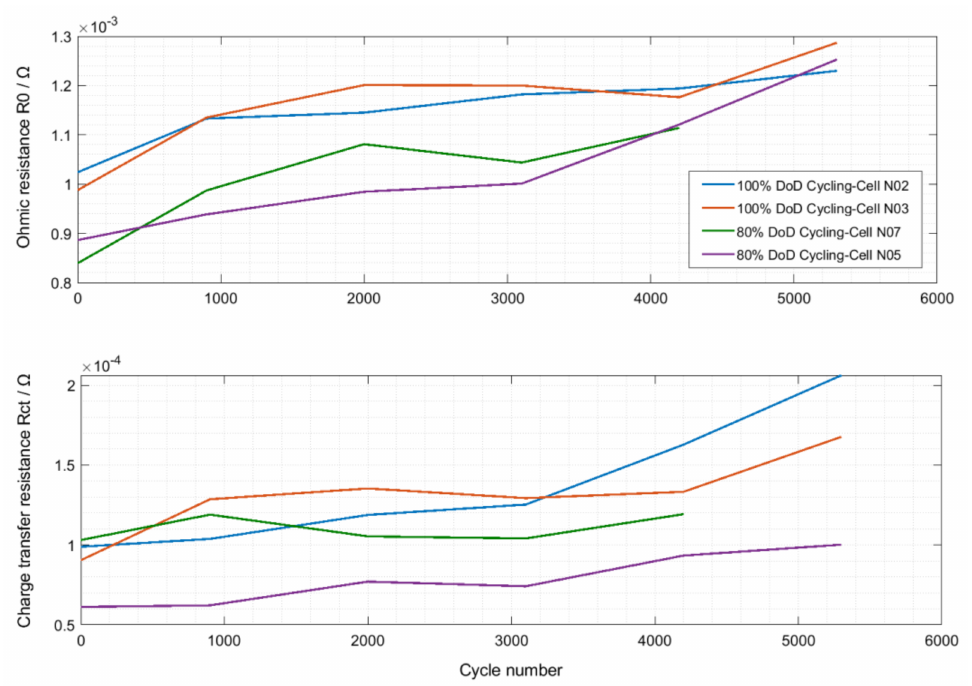
Figure 4. Impedance evolution for cells cycled at different